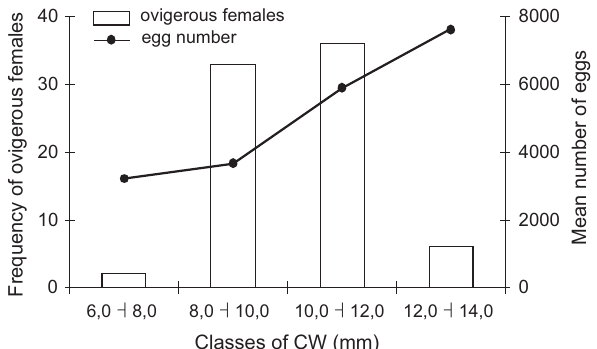
Figure 6. Number of eggs and frequency of ovigerous females in each CW class of U. rapax from Itaipu Lagoon.